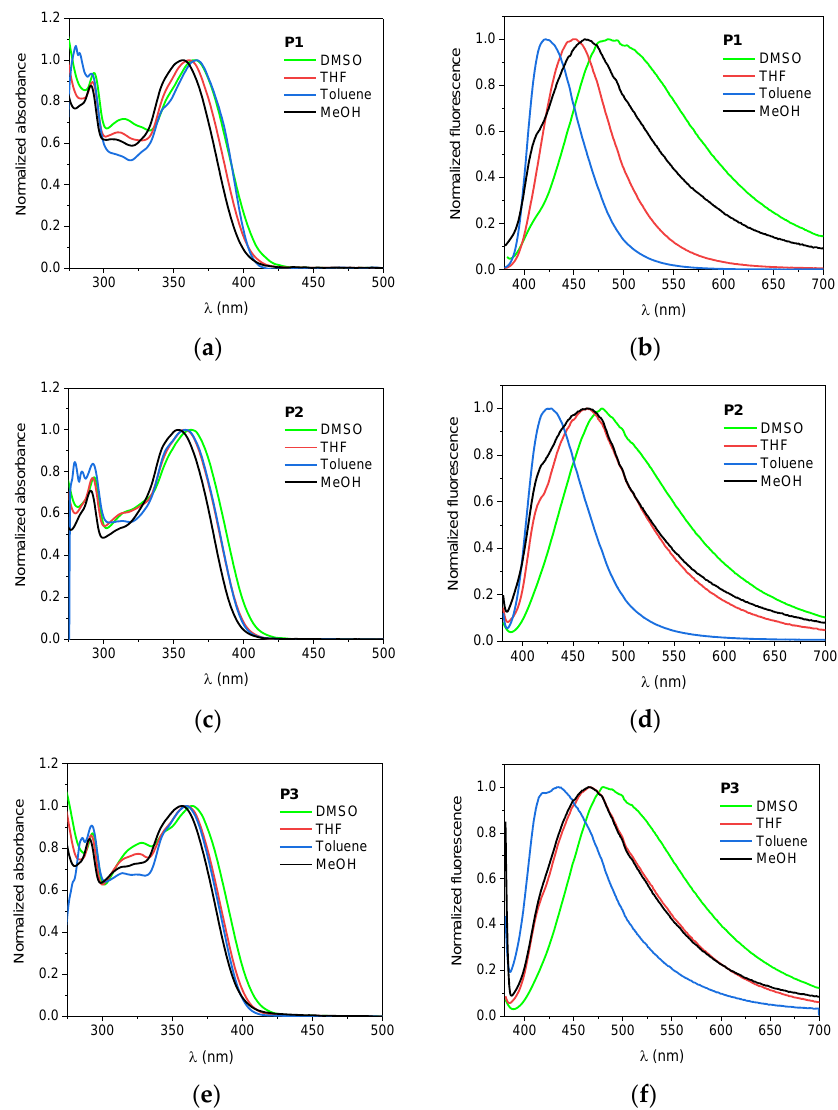
Figure 2. Normalized absorption (left panel: a , c , e ) and fluorescence (right panel; λ EX = 366 nm; b , d , e ) spectra of the dyes in DMSO, THF, toluene, and MeOH. Table 1. Main photophysical parameters a for tested dyes.